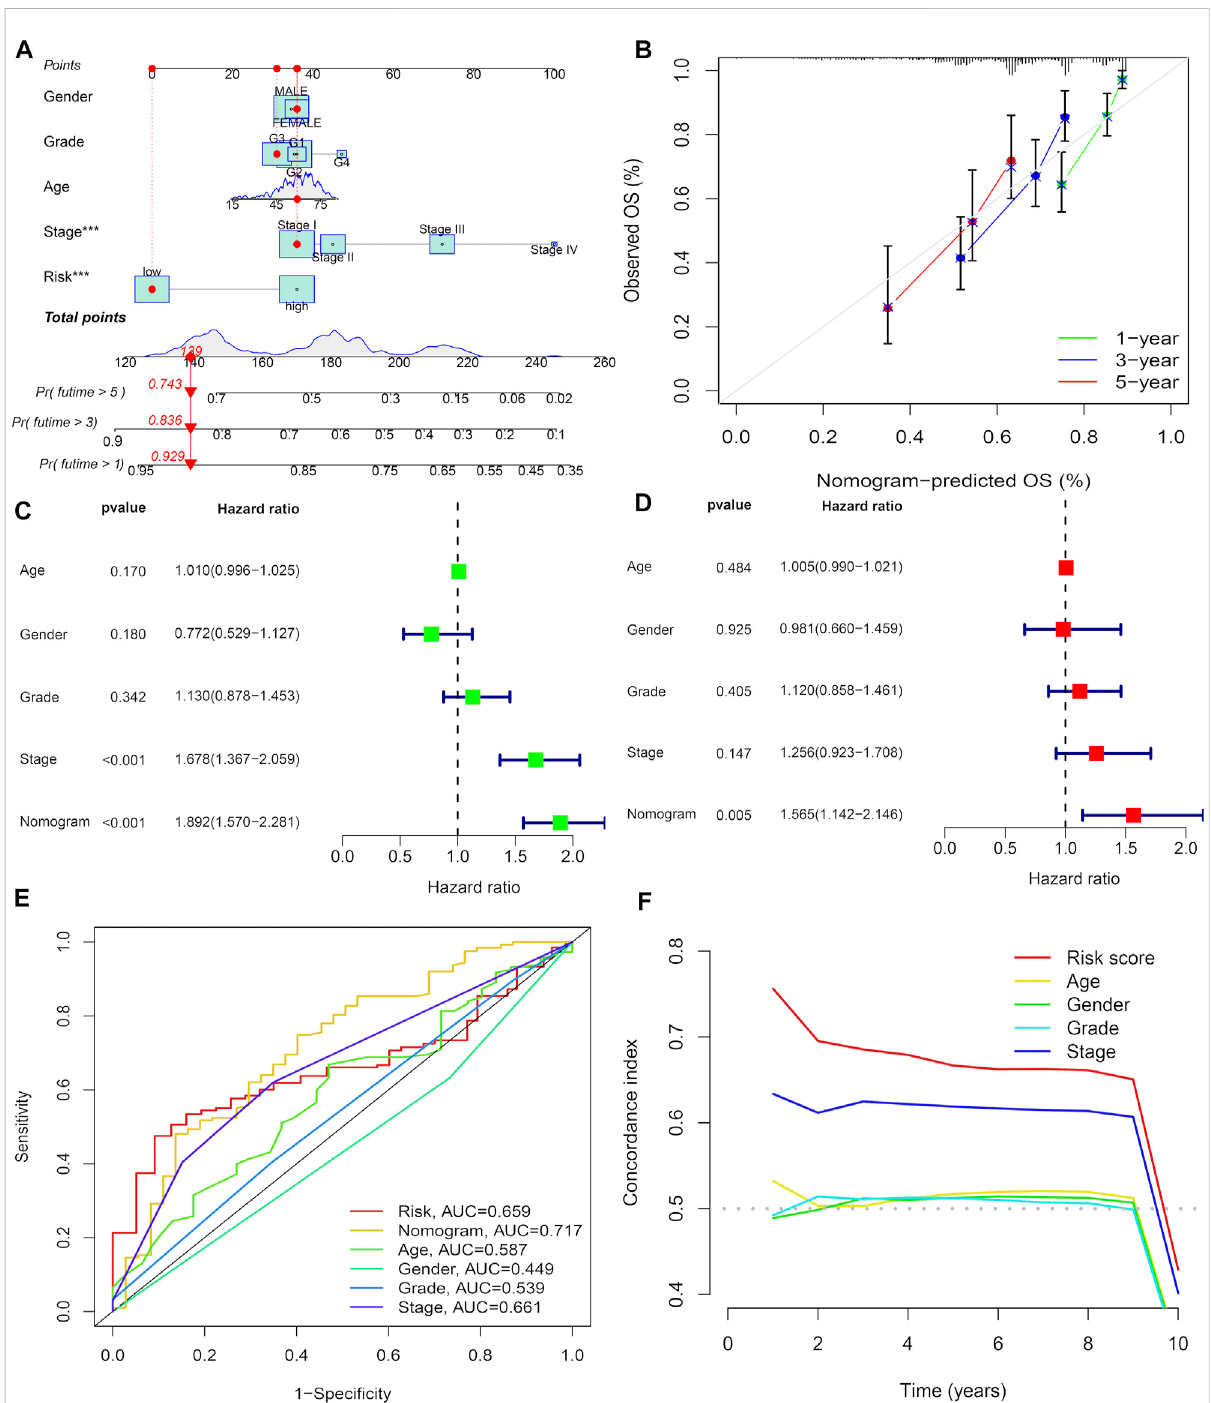
FIGURE 5 Development of a nomogram. (A) Nomogram for predicting 1-,3-, or 5-year OS. (B) Calibration plots for predicting1-, 3-, and 5-year OS. (C) Univariate Cox regression analysis of the nomogram. (D) Multivariate Cox regression analysis of the nomogram. (E) ROC curves for CRs score and clinical pathological characteristics. (F) C-index of the